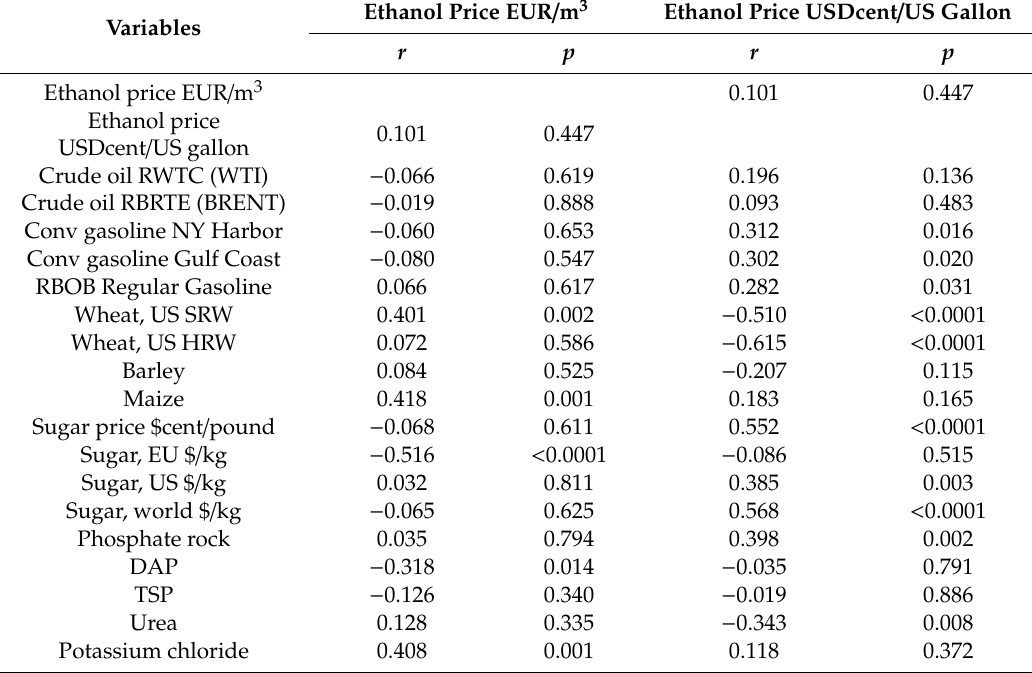
Table 3. Relations between ethanol prices and their major influencing